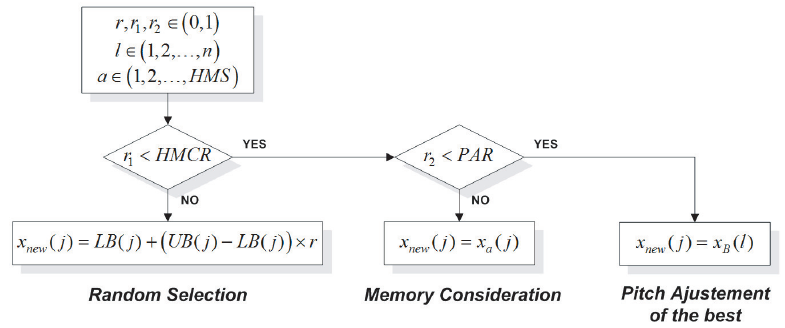
Figure 9. Improvisation process in Global-best Harmony Search (GHS)